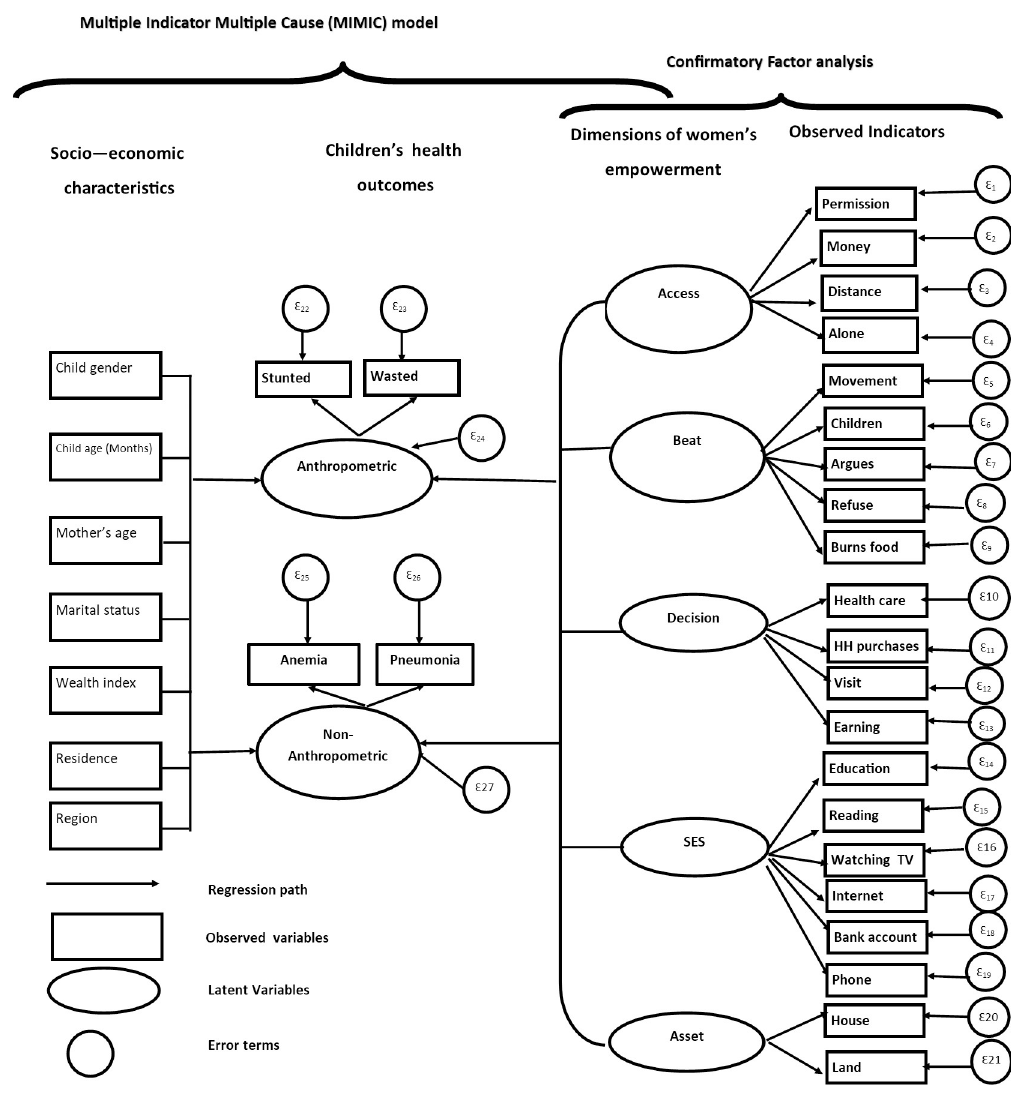
Fig 1. Path diagram of the MIMIC model for women’s empowerment and child health